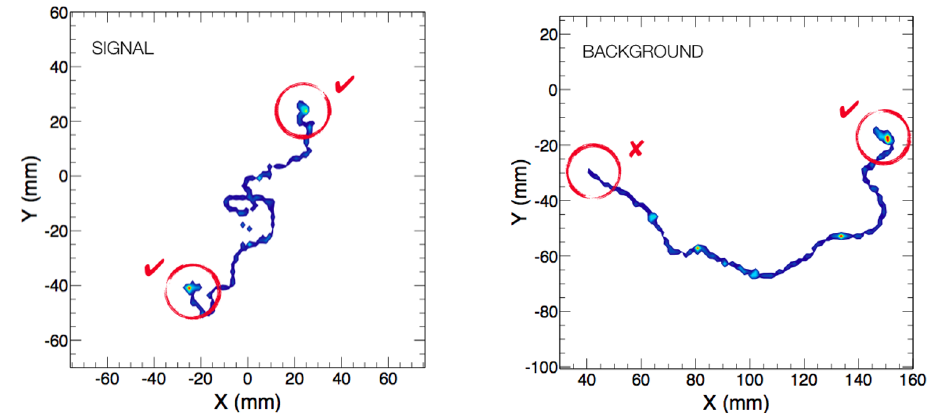
Figure 1 . Simulated GEANT4 signal and background tracks near Q ββ at 15 bar, from